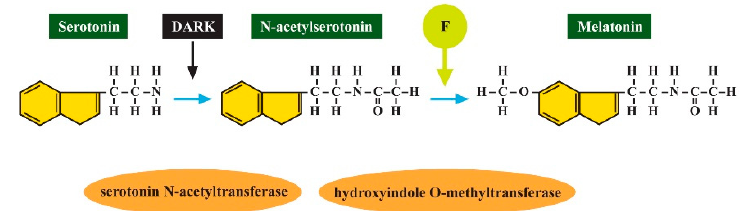
Figure 5. Serotonin is converted to melatonin in dark through the action of two enzymes: serotonin N-acetyltransferase and hydroxyindole O-methyltransferase. F inhibits hydroxyindole O- methyltransferase